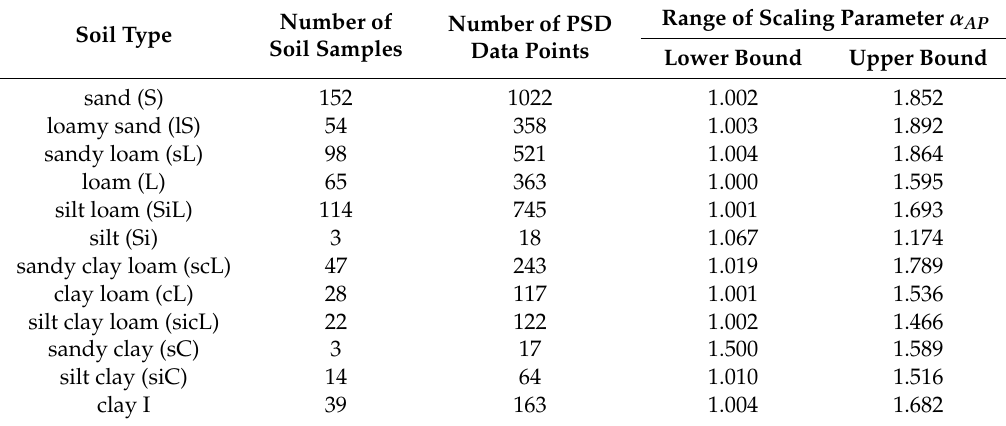
Table 2. Ranges of scaling parameter for 12 soil types in